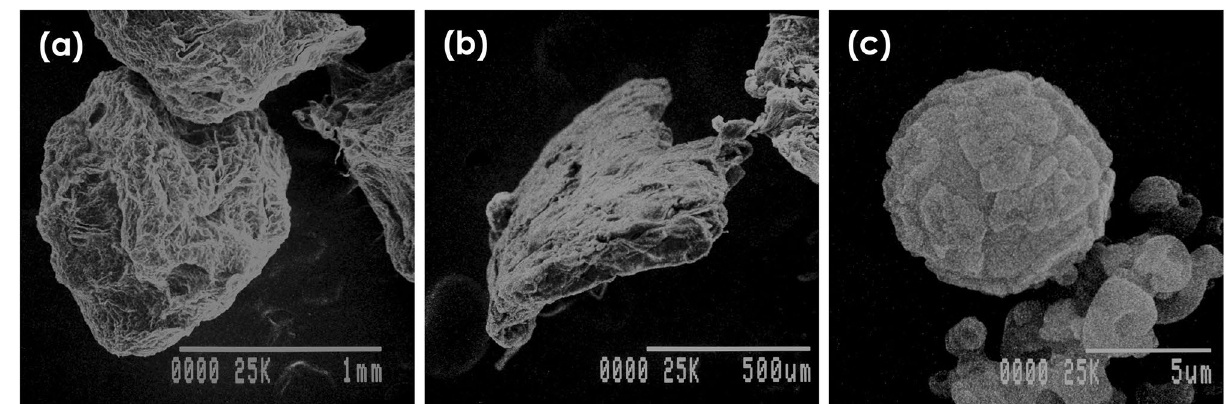
Figure 1. Representative SEM images of alginate-chitosan microcapsules of L22F (as a representative example of the five LAB strains) prepared by the ( a ) extrusion, ( b ) emulsion, and ( c ) spray drying